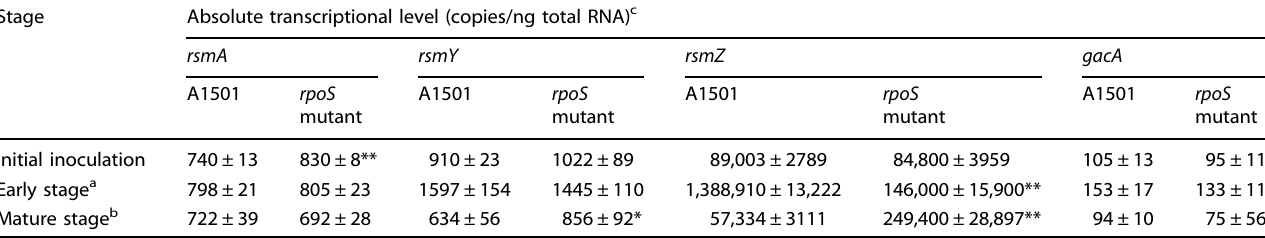
Table 4. Absolute transcriptional levels of the rsmA , rsmY , rsmZ , and gacA genes at different stages of nitrogen- fi xing bio fi lm formation by the P. stutzeri A1501 and rpoS mutant